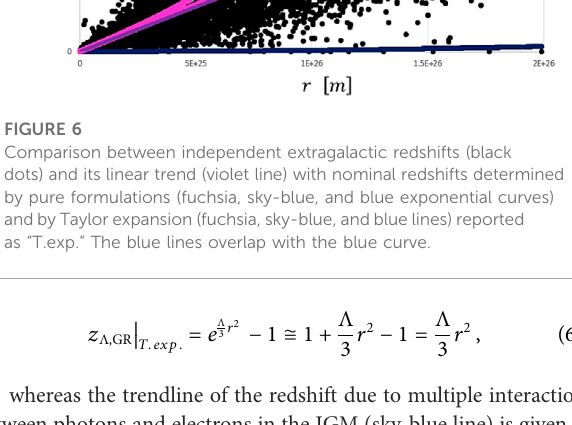
whereas the trendline of the redshift due to multiple interactions between photons and electrons in the IGM (sky-blue line) is given by summed-up contribution (fuchsia line) of Eqs 67, 68 is